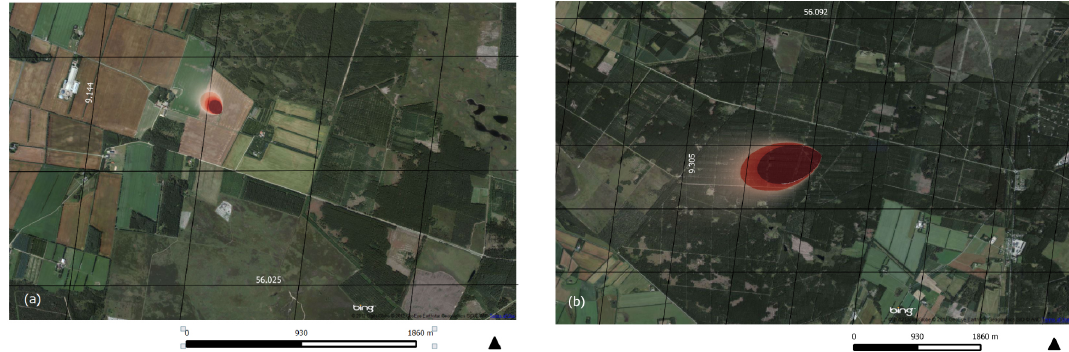
Figure 1. Flux towers at the two sites used for evaluating the model performance: Voulund (VOU, a ), and Gludsted (GLU, b ). The grid indicates the location of MODIS pixels in MODIS sinusoidal projection. The red plumes originate from the locations of the flux towers and are an example of a typical flux measurement footprint of the EC system mounted on each of the